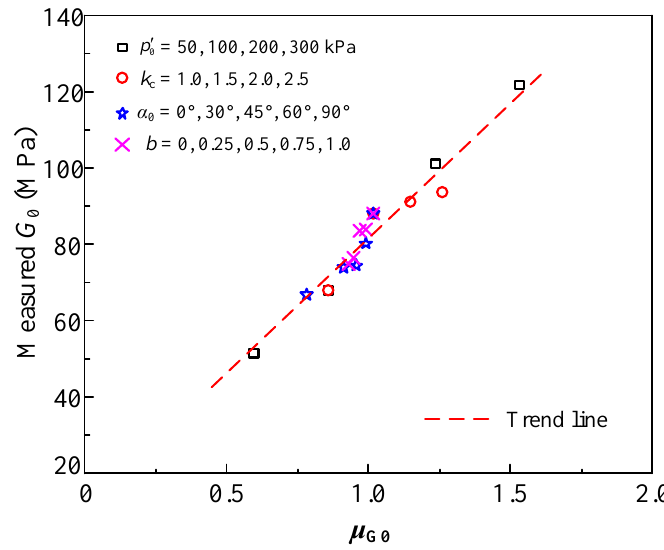
Figure 8. The correlation between the experimental G 0 versus µ G0 .